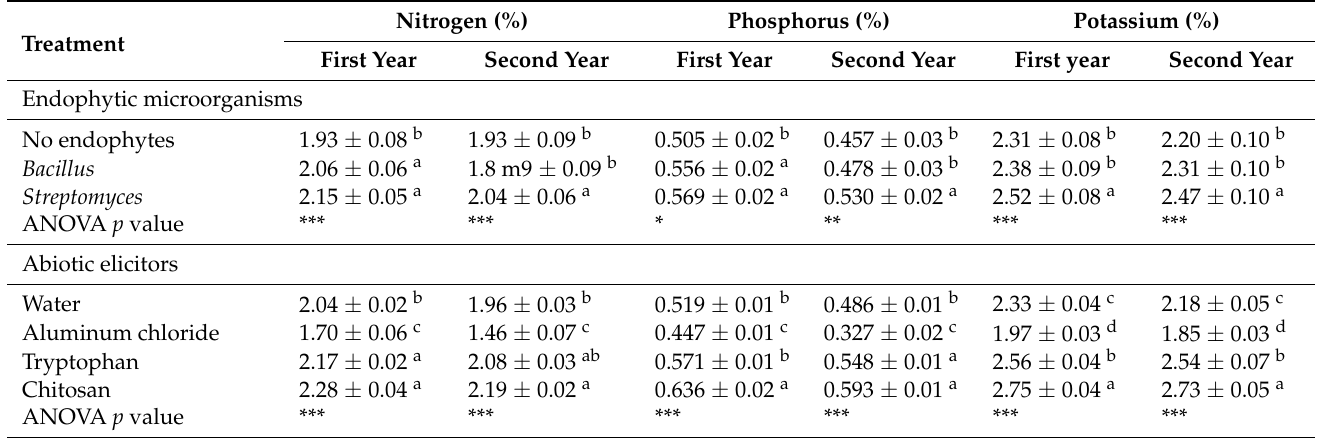
Table 2. Effect of endophytic microorganisms and abiotic elicitors on the percentage of nitrogen, phosphorus, and potassium in periwinkle plant shoot in both seasons. Means of five replicates are presented with ±